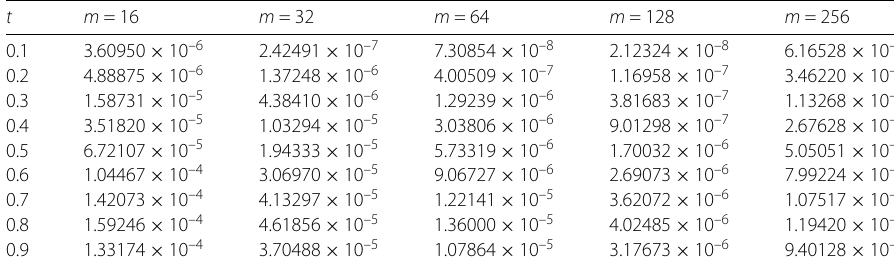
Figure 7 Numerical solutions for m = 64, ρ = 1.45, and distinct values of α